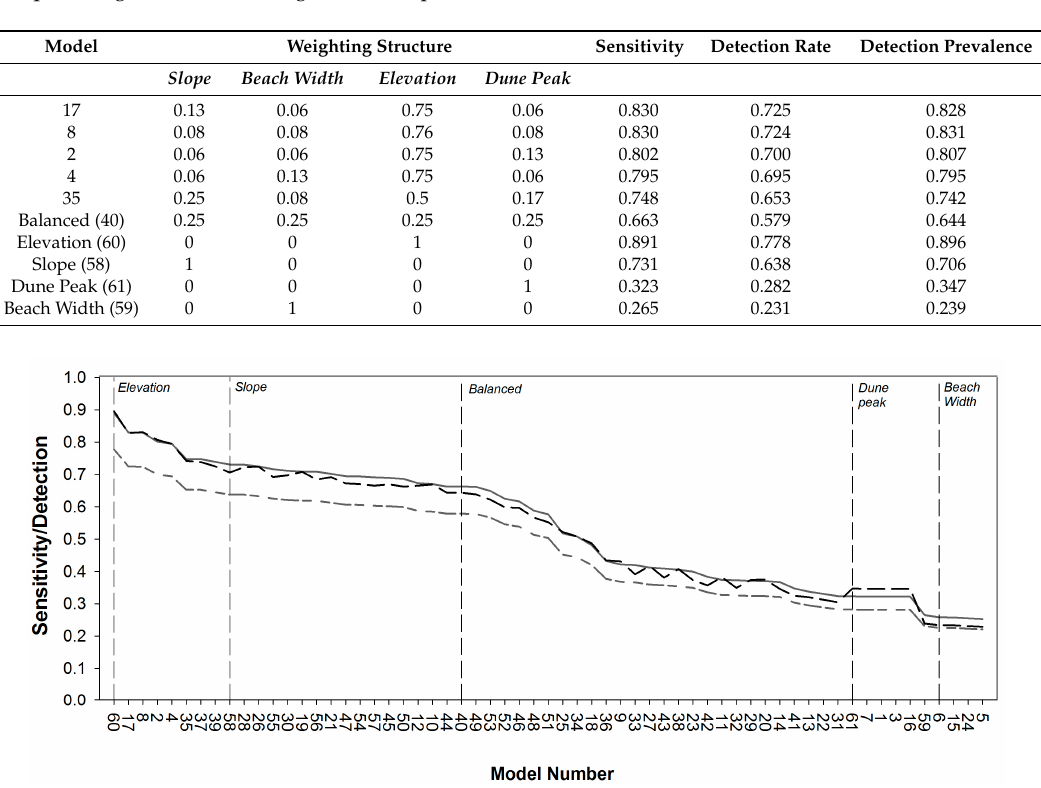
Table 2. Model sensitivity, detection rate, and detection prevalence of top five models as determined through comparative analysis of contingency tables from 57 candidate models. Results from equal-weight (balanced design) and one-parameter models are also listed.